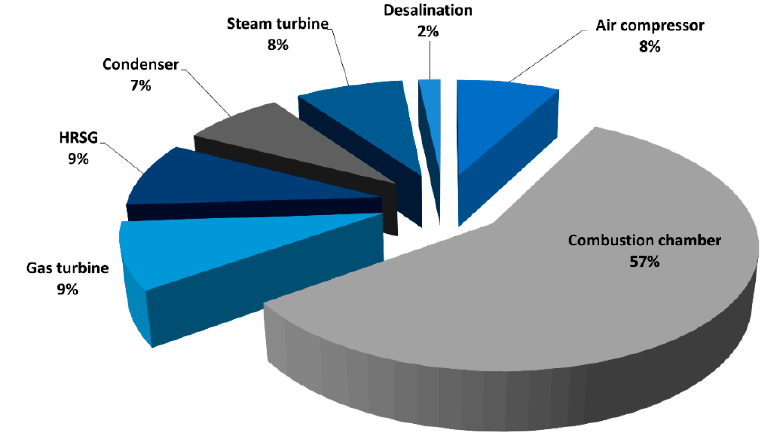
Figure 5. Exergy destruction distribution between the main system components. HRSG, heat recovery steam